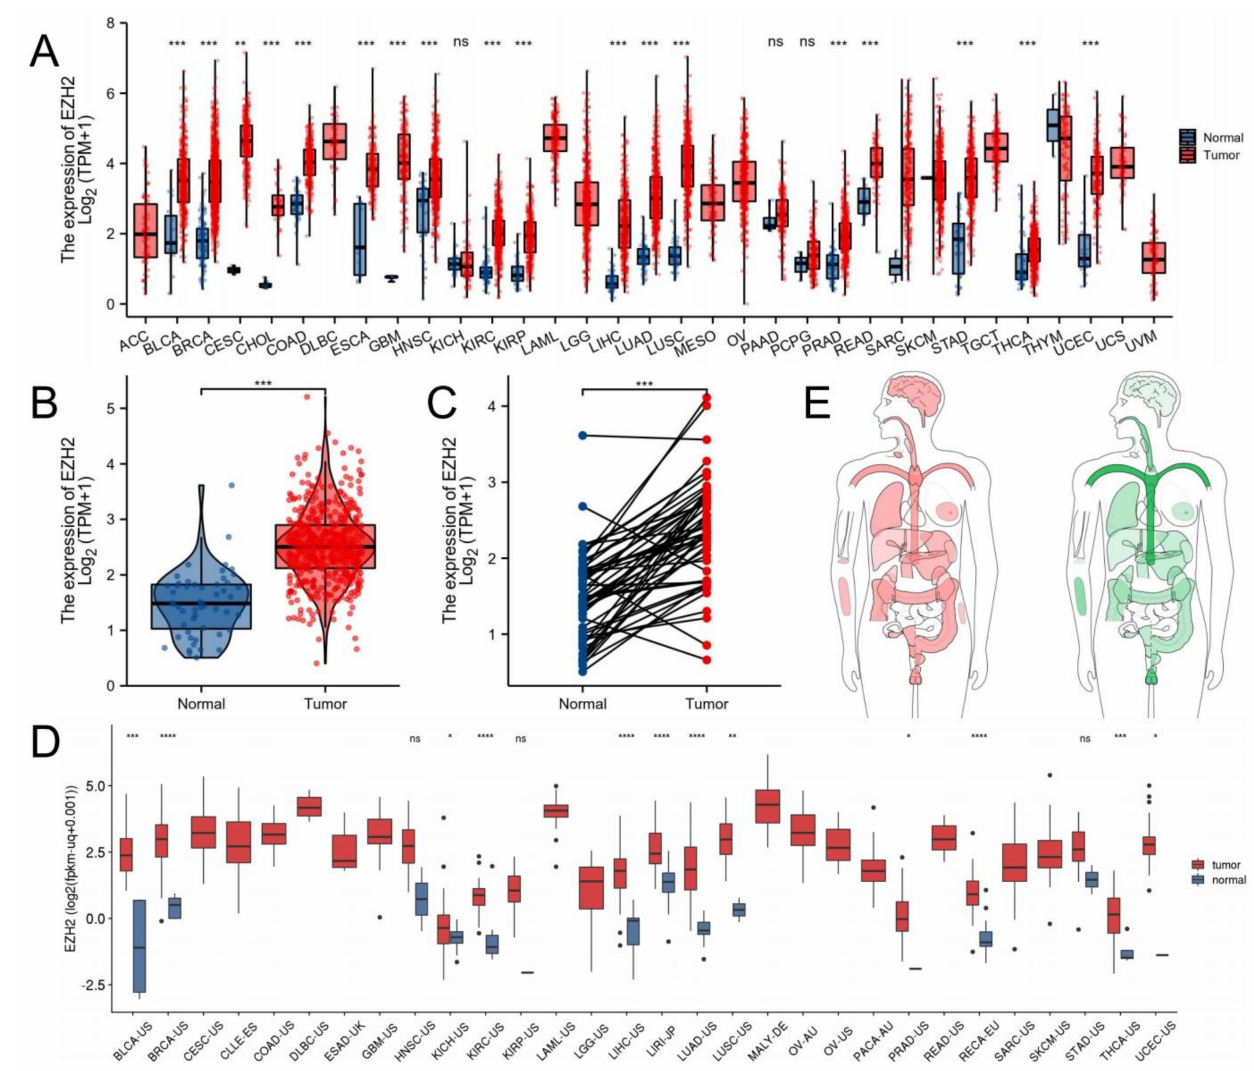
Figure 1. EZH2 mRNA expression levels between tumor and normal samples. EZH2 mRNA expression levels in ( A ) pan-cancer and ( B ) PCa from TCGA database. ( C ) The EZH2 mRNA expression by pairwise boxplot in Pca from TCGA. ( D ) EZH2 mRNA expression levels in pan-cancers from PCAWG. ( E ) Interactive bodymap of EZH2 in humans using GEPIA database. No significance, p -values < 0.05, 0.01, 0.001 and 0.0001 were presented as “ns”, “*”, “**”, “***”, and “****”,